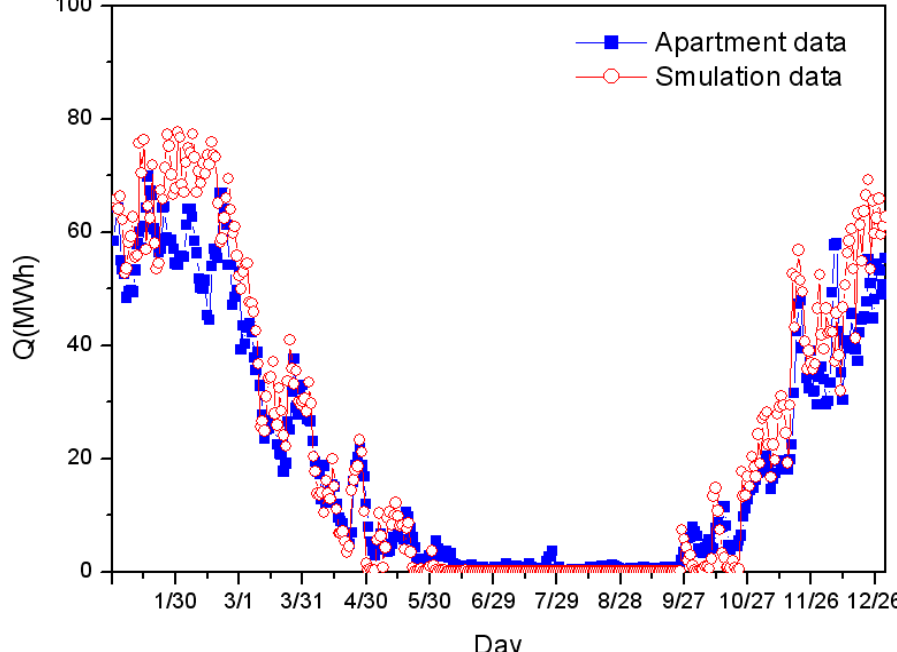
Figure 14. Annual variation of heating load of the model group energy apartment building.